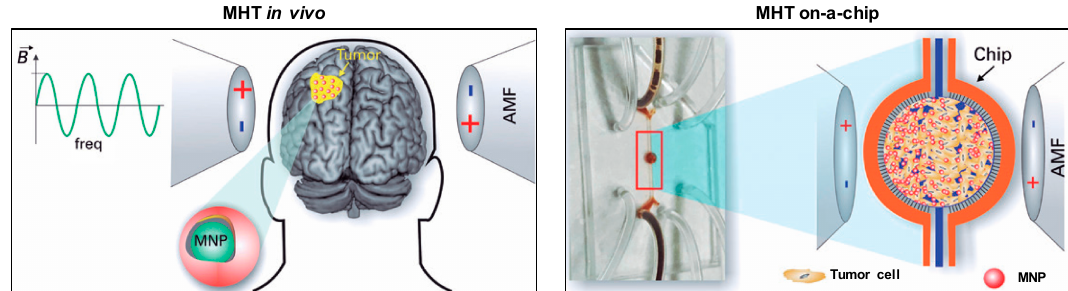
Figure 2. Schematic comparison between magnetic hyperthermia (MHT) in vivo and MHT on a tumor on-a-chip. In vivo, magnetic nanoparticles (MNPs) injected into the tumor are heated up by an alternating magnetic field (AMF). On the tumor-on-a-chip model, MNPs are injected using microfluidics into the central compartment where a 3D tumor structure was formed. The whole chip is then submitted to the AMF. Adapted with permission from Reference [15]. Copyright 2019 Instituto Israelita de Ensino e Pesquisa Albert Einstein.